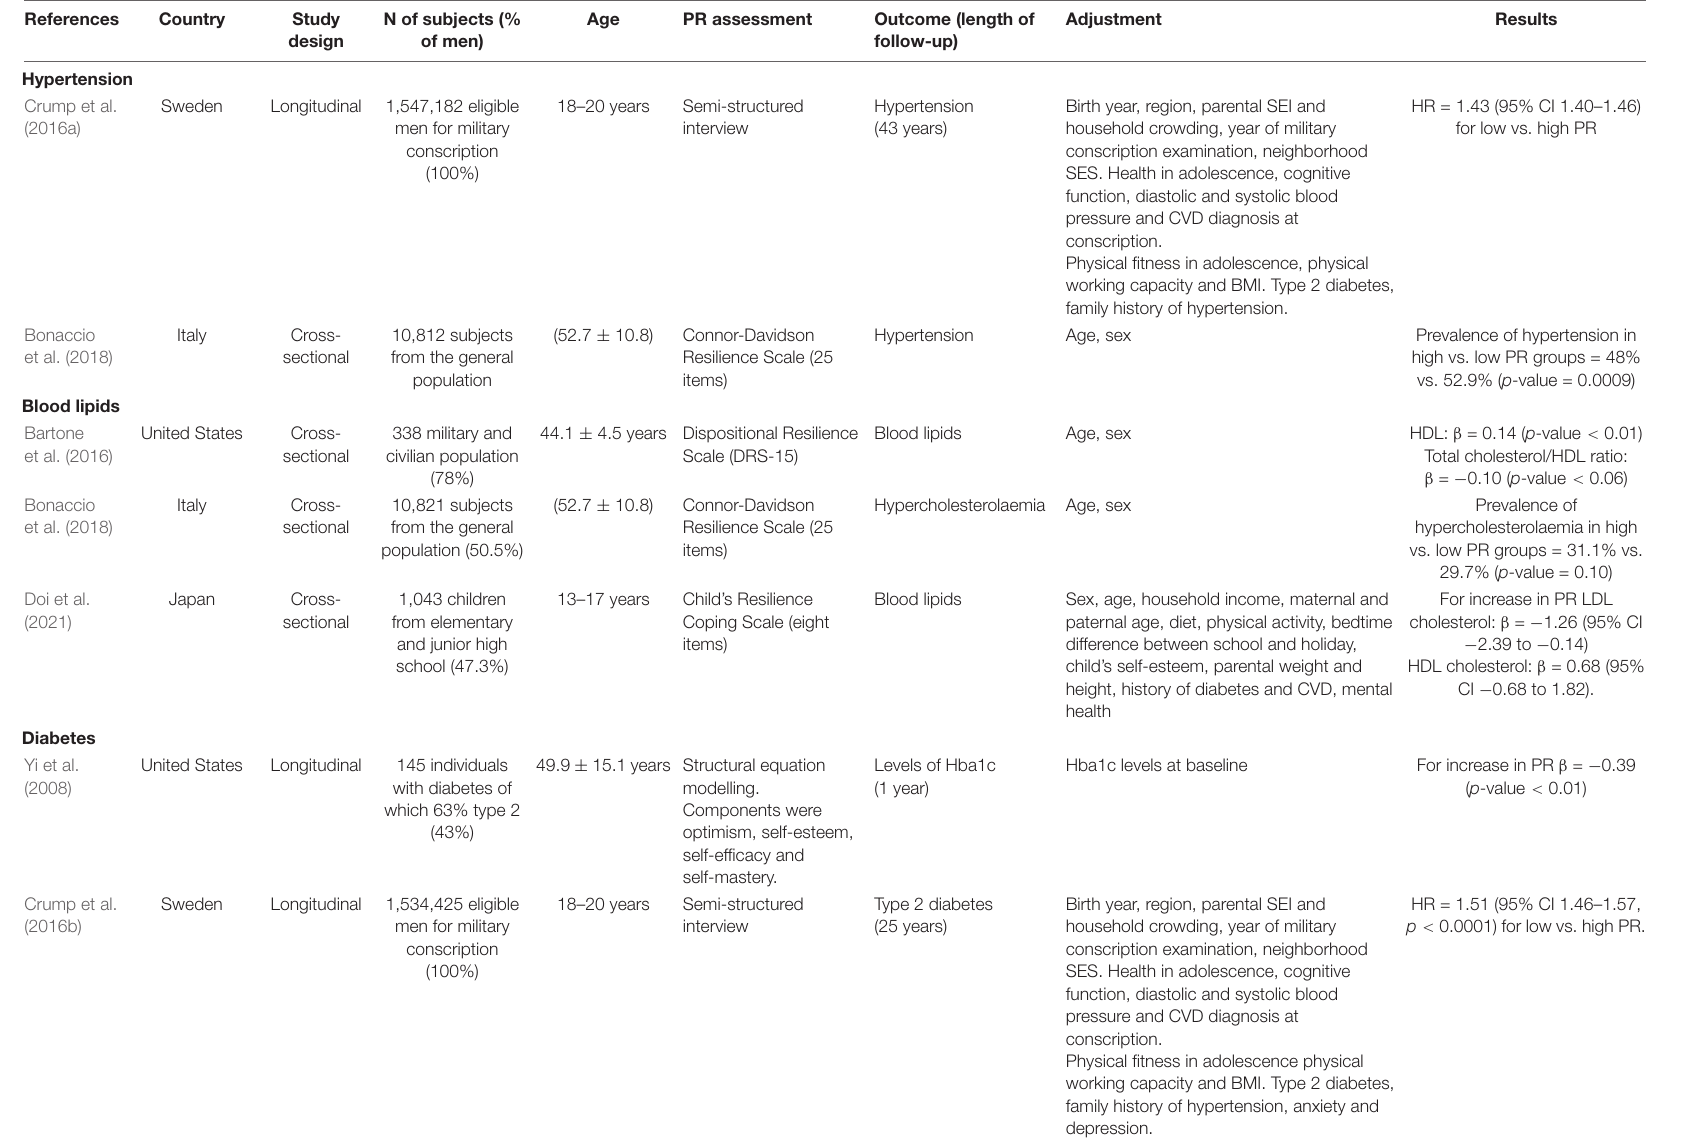
TABLE 2 | Psychological resilience (PR) and metabolic